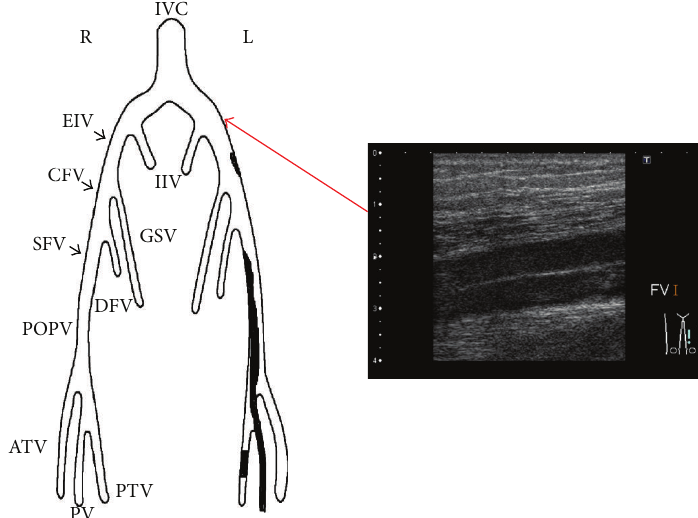
Figure 7: After anticoagulant therapy and EVT, the venous thrombi in the left leg decreased as seen in the ultrasonography of leg